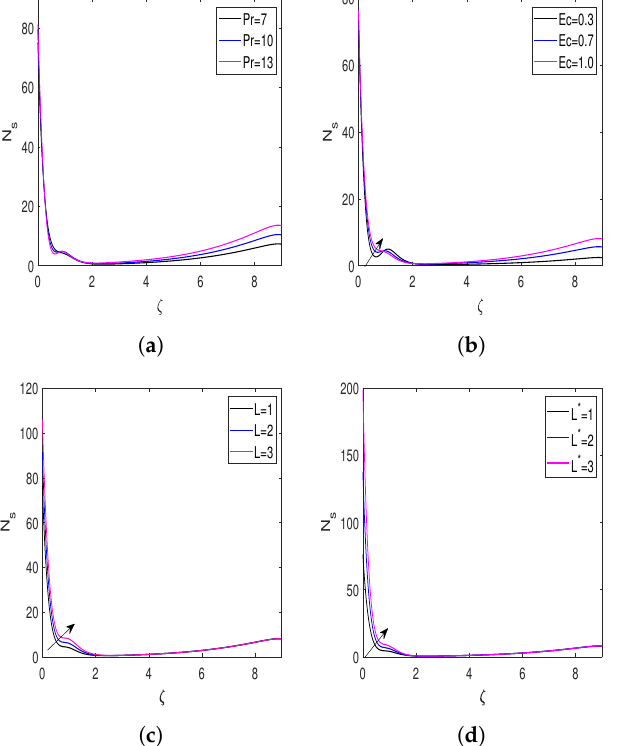
Figure 8. Variation in entropy for different flow parameters. ( a ) Entropy versus Pr ; ( b ) entropy versus Ec ; ( c ) entropy versus L ; and ( d ) entropy versus L ∗ .